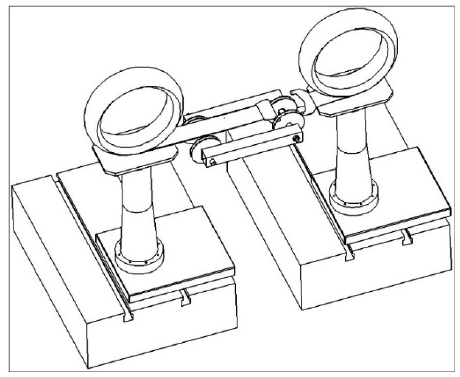
Figure 7. The steel cable/fabric belt system kinematics. F1 is the pneumatic actuator force and F2 is the chain/front wheel hub reaction.